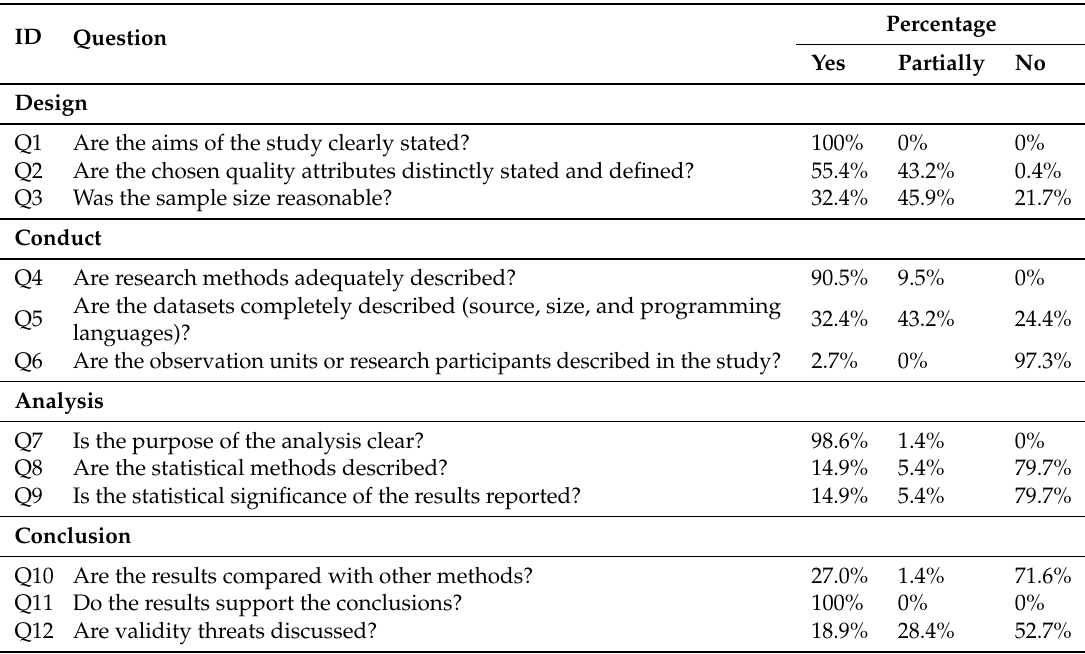
Table 6. Quality assessment questions and